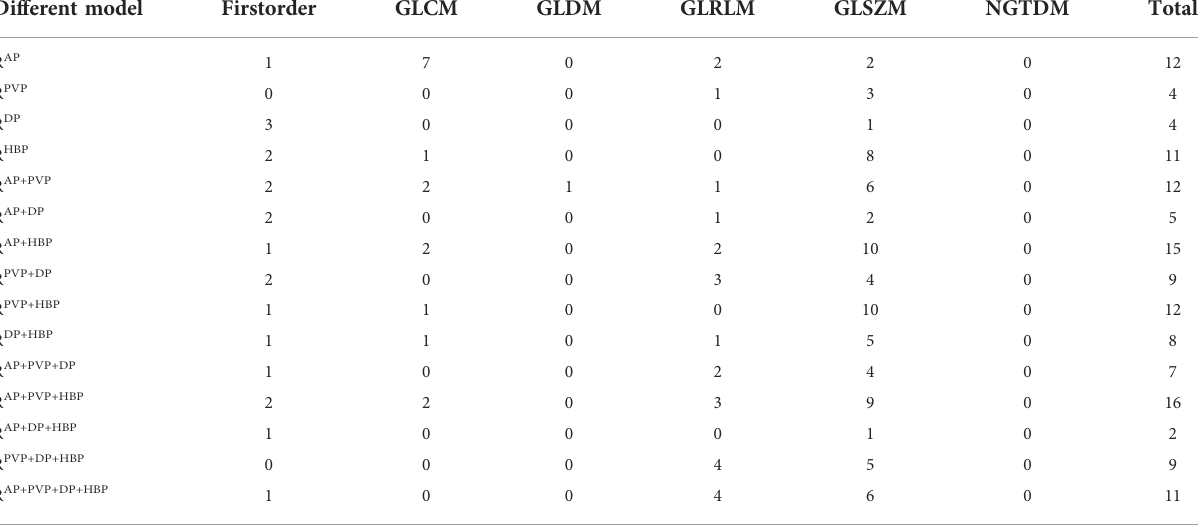
TABLE 3 Selected radiomics features of the proposed models. Different